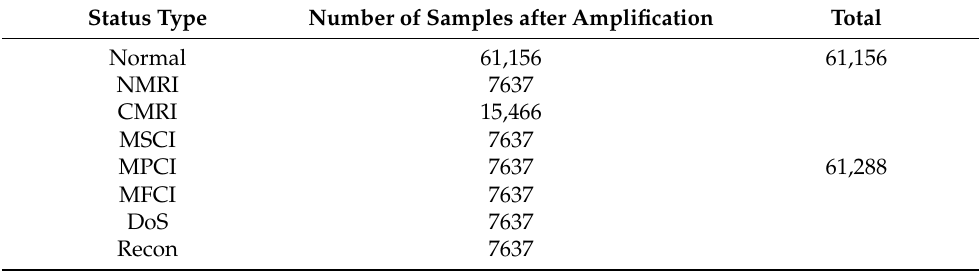
Table 5. Data set after amplification of attack type